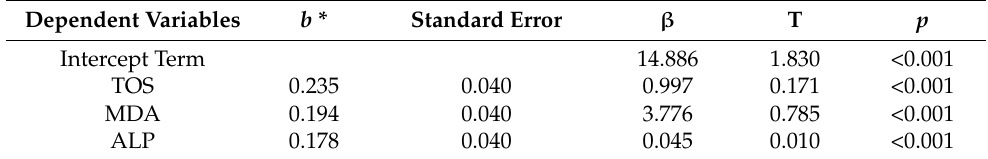
Table 4. Backward stepwise multiple linear regression analysis of predictors of CER concentration. Dependent Variables